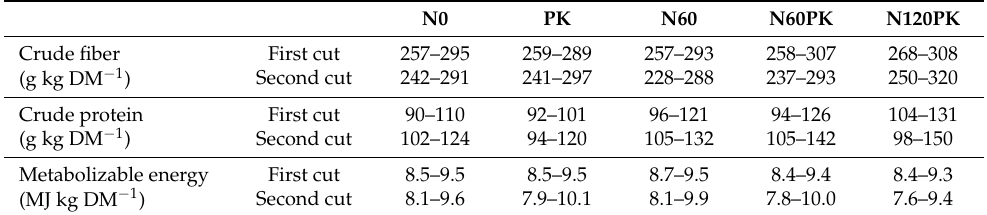
Table 2. Forage quality shown as minimum and maximum yearly means of the six sampling years for the first and second cuts. The raw data are provided as a Supplementary File (Table S1).